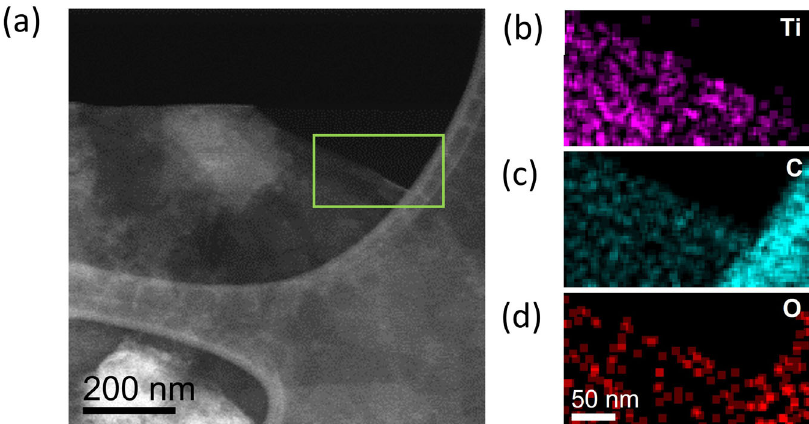
Fig. 5 STEM-EDX maps of the MXene material post OER. a STEM image, b corresponding Ti K α map, c corresponding C K α map and d corresponding O K α